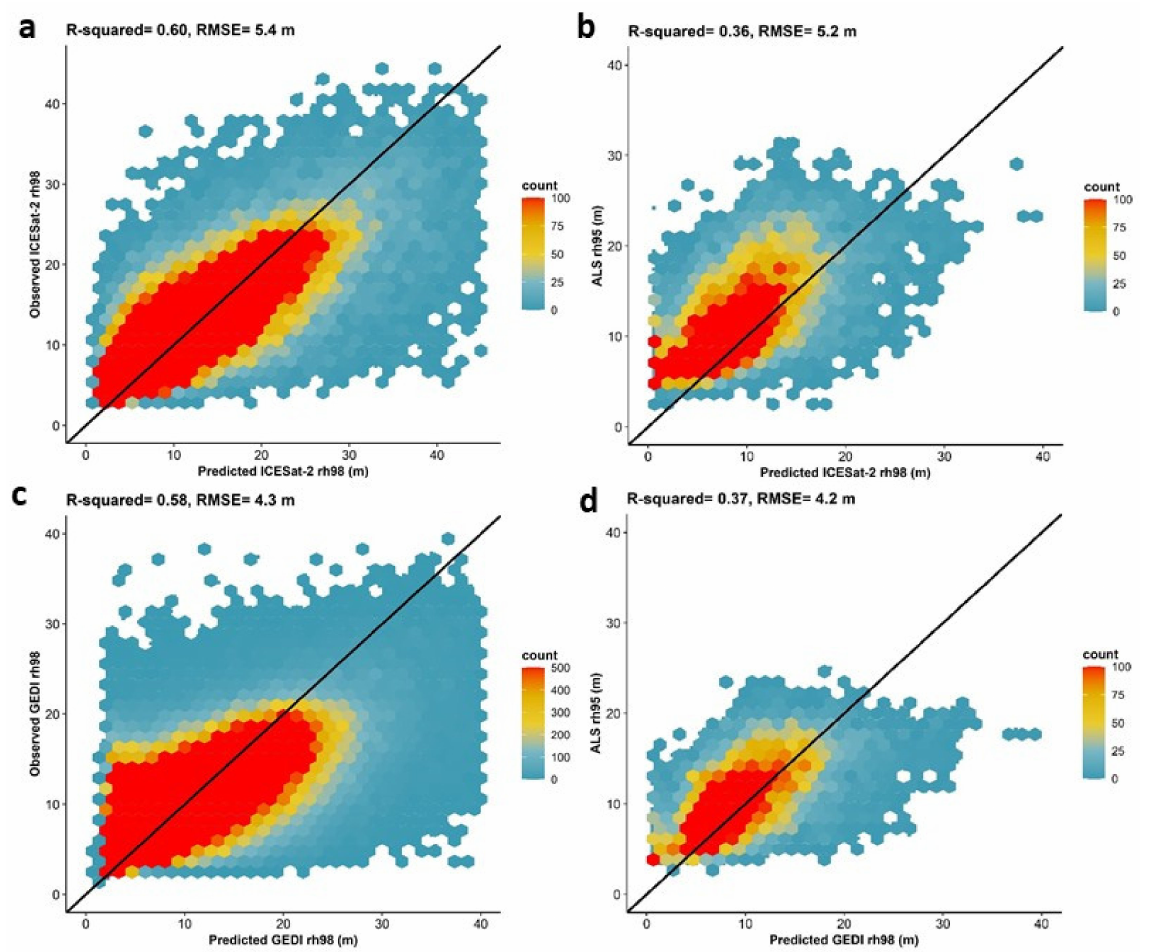
Figure 2. Relationship between the measured and estimated canopy height values using an indepen- dent validation assessment with GEDI and ICESat-2 sample set ( a , c ) and a random forest algorithm, and the resulting canopy height maps compared to ALS point data ( b , d ). Point density is indicated with a blue (low-density regions) to red (high-density regions) color gradient. The black line repre- sents a 1:1 linear fit line. ( a ) Internal validation using ICESat-2 ATL08 modeled using 14 covariates and 145,987 points, and 62,566 points used for test. ( b ) Validation using 18,090 ALS points versus ICESat-2 canopy height map. ( c ) Internal validation using GEDI L2A modeled using 14 covariates and 874,548 points, and 374,806 points used in the test. ( d ) Validation using 18,090 ALS points versus GEDI canopy height